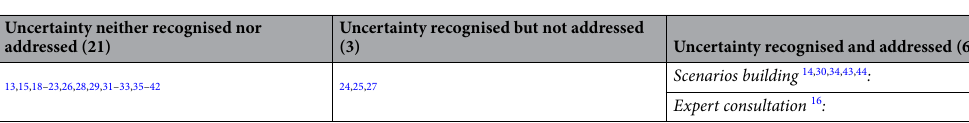
Table 2. Approaches concerning uncertainty in the literature and the methods employed to address it.